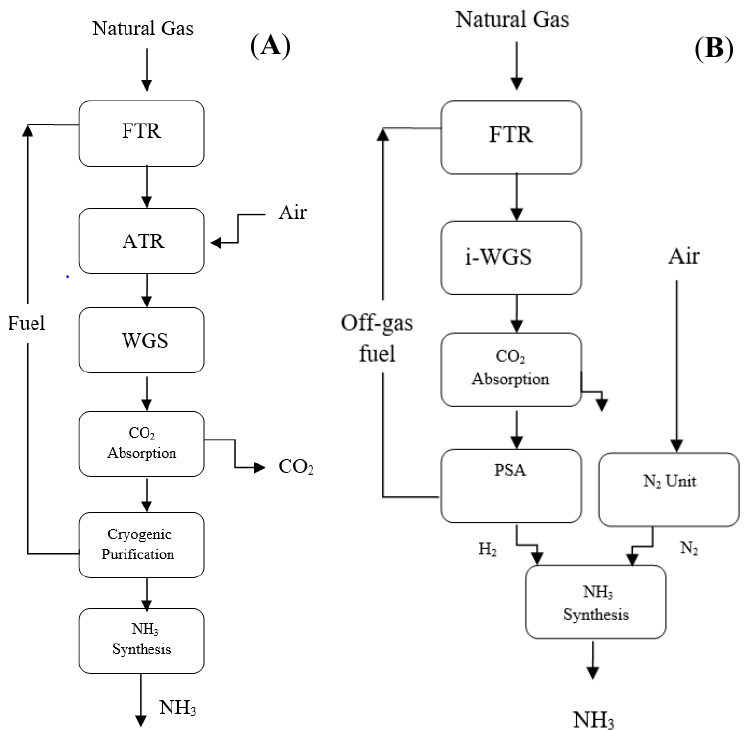
Figure 10. Block flow diagrams of different ammonia production technologies: ( A ) KBR ( B ) LAC, reproduced from the references [35].